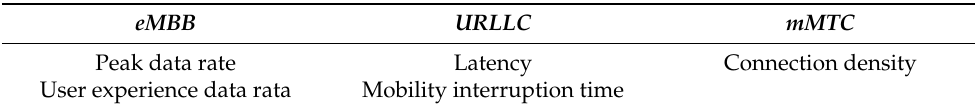
Table 1. Key performance indicators of 5G per traffic type.